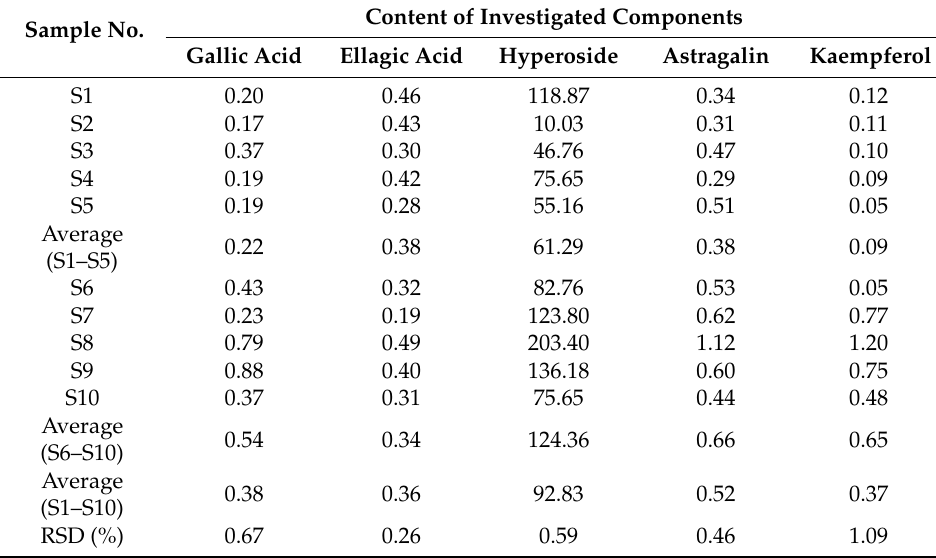
Table 4. Contents of 10 components in R. rugosa ( n = 3, mg/g).